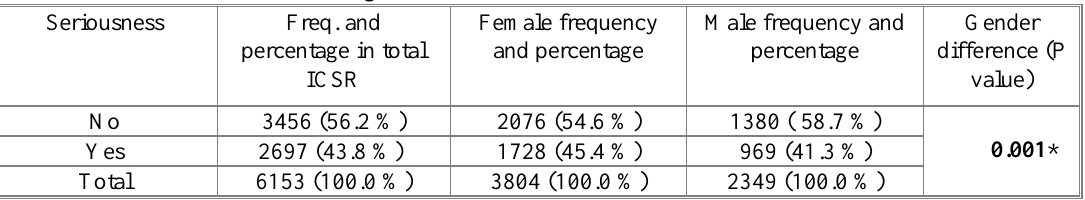
Freq. and percentage in